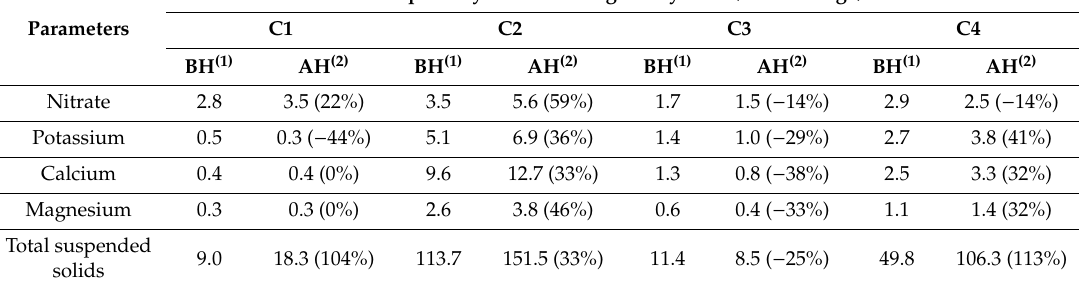
Table 4. Exportation (kg ha − 1 year − 1 ) of nitrate (NO 3 − ), potassium (K + ), calcium (Ca 2 + ), magnesium (Mg 2 + ) and total suspended solids (TSS) one year before (BH) and one year after (AH) harvesting at catchments C1, C2, C3 and